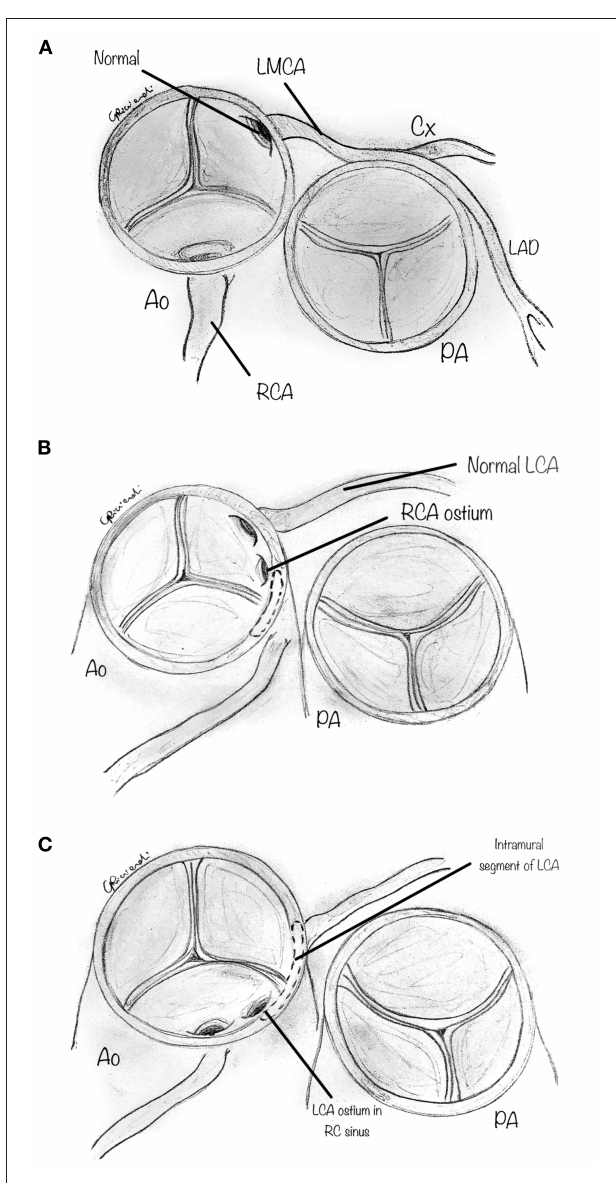
FIGURE 1 | Diagram showing cross section aortic view : (A) Normal coronary artery anatomy: the left main coronary artery (LMCA) gives origin to the Left anterior descending (LAD) and circumflex (CX) coronary artery, which arise from a common stem from the left aortic sinus; the right coronary artery (RCA) arises from the right aortic sinus; (B) the most common type, i.e., anomalous aortic origin of the RCA from the left sinus (AAORCA), with an intramural segment; (C) the most lethal type, i.e., anomalous aortic origin of the LCA from the left sinus (AAOLCA), with an intramural segment.